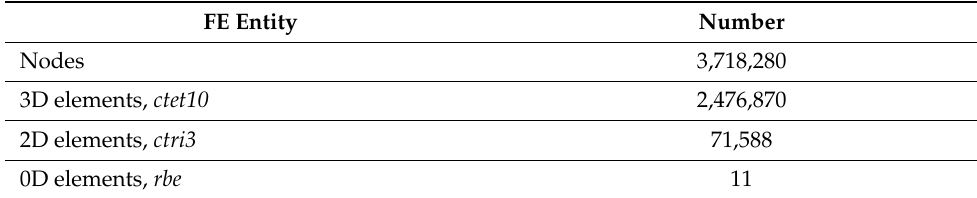
Figure 5. Three ‐ dimensional FE model details. ( a ) 3D model; ( b ) inner walls; ( c ) equivalent hydraulic loads on plugs; ( d ) constraints. Table 5. Three-dimensional FE model total number of nodes and